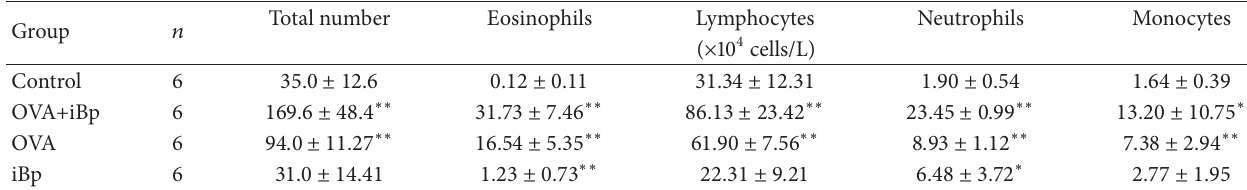
Figure 1: (a) 𝑅 𝐿 as a marker of AHR induced by MCh in normal ( 𝑛 = 6 ), OVA+iBp ( 𝑛 = 8 ), iBp ( 𝑛 = 6 ), and OVA rats ( 𝑛 = 6 ); (b) Cdyn as a marker of AHR induced by MCh (mean ± SEM; ∗ 𝑃 < 0.05 ; ∗∗ 𝑃 < 0.01 versus normal rats). Table 2: Antigen-induced lung inflammatory cells in bronchoalveolar